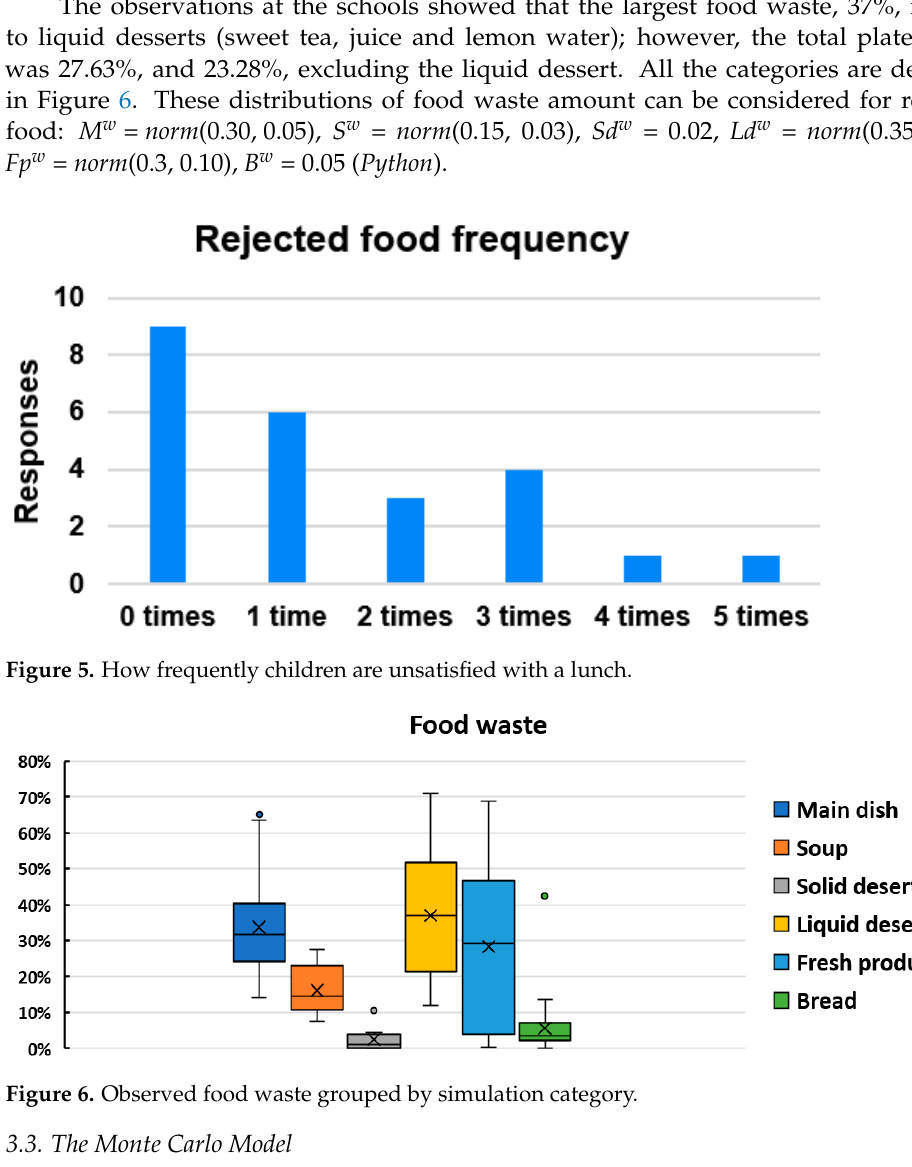
Figure 6. Observed food waste grouped by simulation category.